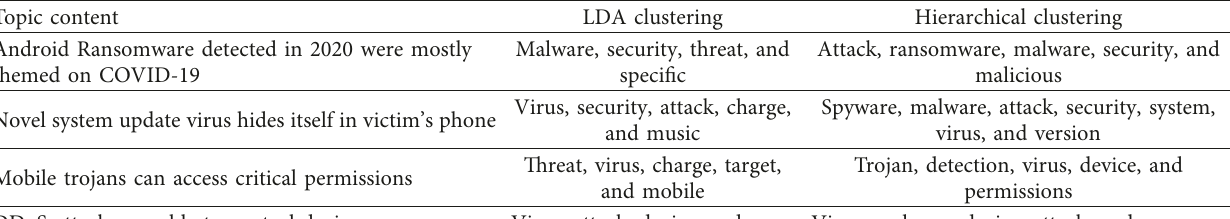
Table 12: Topic words extracted using LDA and hierarchical clustering.